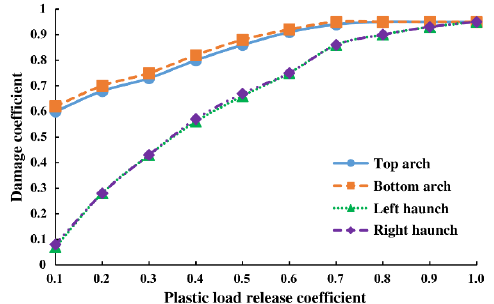
Figure 10. Damage coefficient variation with plastic load release coefficient of type V surrounding rock.